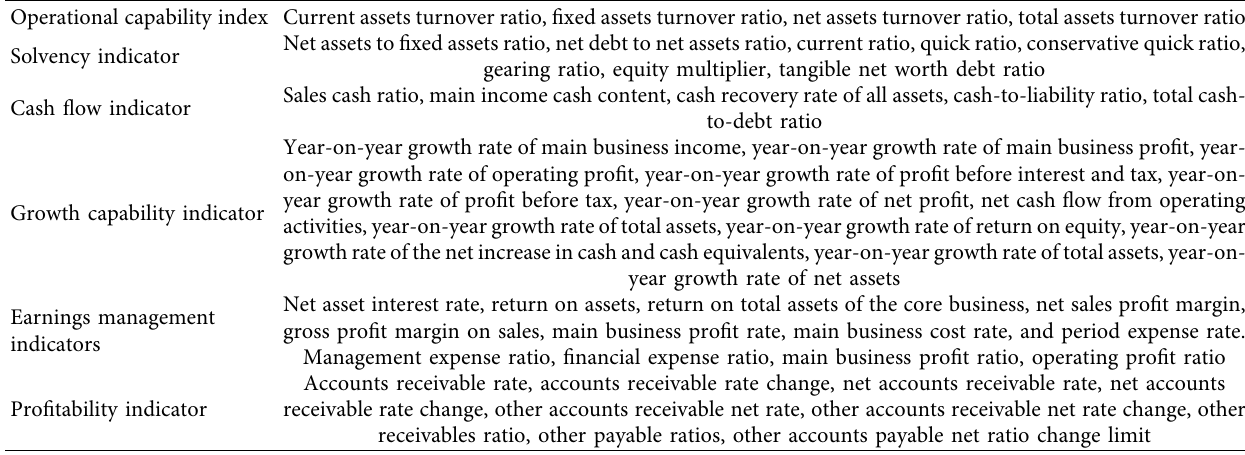
Table 3: List of financial indicators to be